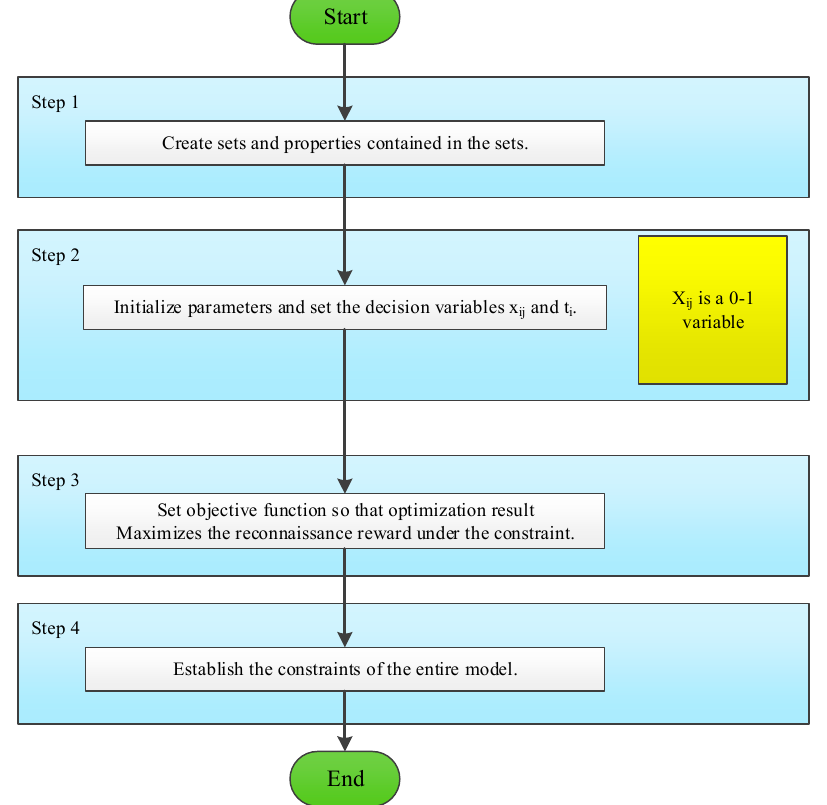
Figure 2. The flow chart of the proposed method based on Lingo.